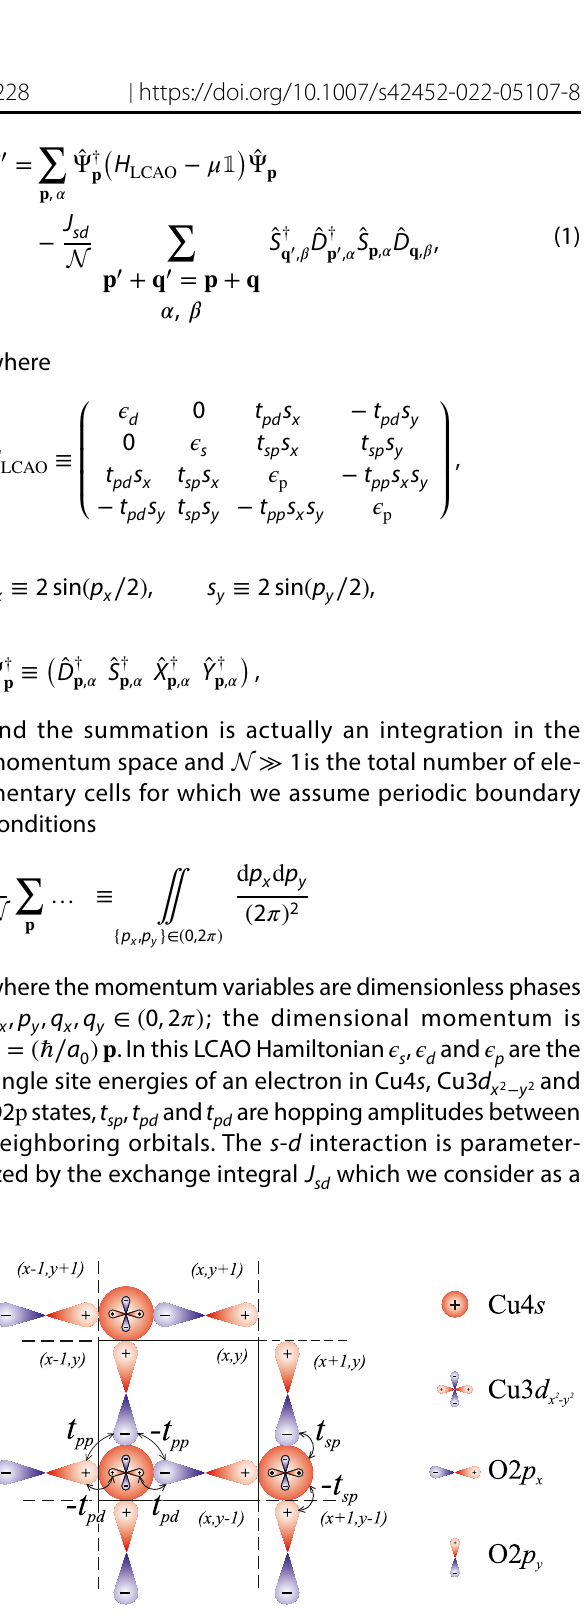
Fig. 1 Single electron processes in the conducting CuO 2 plane of layered cuprates after Ref. [16, Fig. 1.1]. LCAO is the basis of the chemical intuition. We have Hilbert space spanned over Cu4 s , Cu 3 d x 2 − y 2 , O 2 p x , and O 2 p y states. The LCAO Hamiltonian is param- eterized by transfer integrals t pd , t sp , and t pp and single site energies 𝜖 𝜖 𝜖 d , s ,